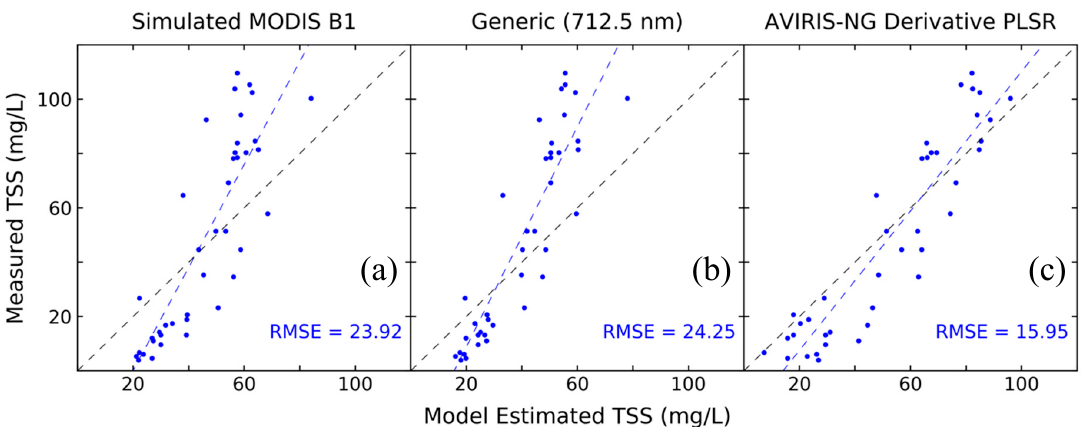
Figure 6. Validation results for total suspended solids (TSS, mg / L) from the Peace–Athabasca Delta field spectrometer dataset with the ( a ) simulated MODIS band 1 regression model, ( b ) generalized model at 712.5 nm, and ( c ) first derivative-based PLSR model. Similar to Figure 5, the PLSR results here again show superior performance, with a lower RMSE and a line of best fit closer to the 1:1 line. Table 3 contains additional error metrics for the latter model.